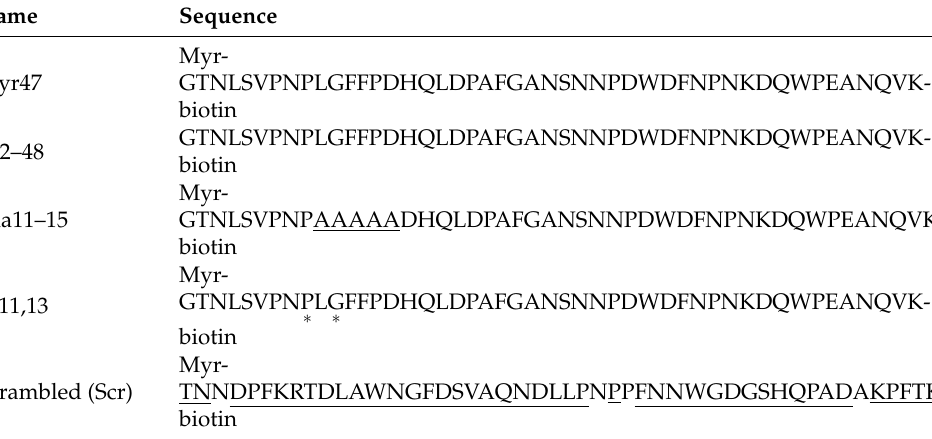
Figure 3. In vitro direct interaction of Myr47 with LPs. ( A ) Interaction of Myr47 with LPs analyzed by AlphaScreen assay. ( B ) Interaction of Myr47 or aa2–48 with LPs analyzed by AlphaScreen assay. Data are shown as means ± S.D. ( n = 3). Table 1. Myr47 and its mutant